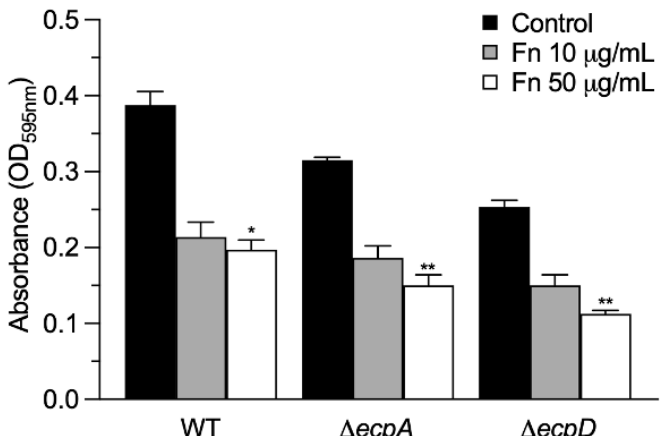
Figure 4. Binding of immobilized Fn to EPEC preincubated with Fn. ELISA was used to quantitatively determine the binding of immobilized Fn to EPEC strains previously incubated with soluble Fn at two different concentrations for 1 h. BSA was used as a negative control. Data are the mean of three experiments performed in triplicate (Kruskal–Wallis test, * p < 0.05; ** p < 0.01).